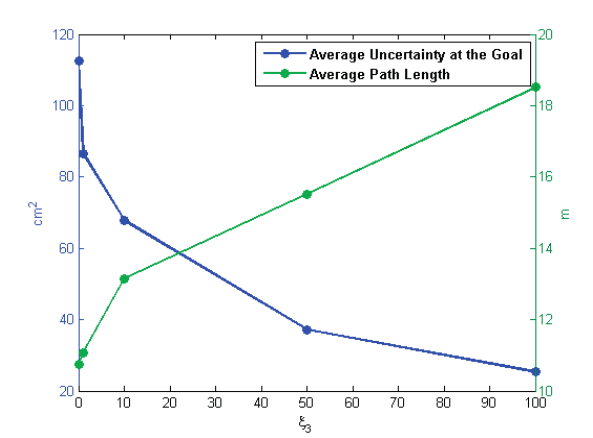
Figure 13. Comparison of average path length and average uncertainty cost at the goal. Data points correspond to different values of the uncertainty cost weighting factor (Equation (19)): ζ 3 = {0, 1, 10, 50,